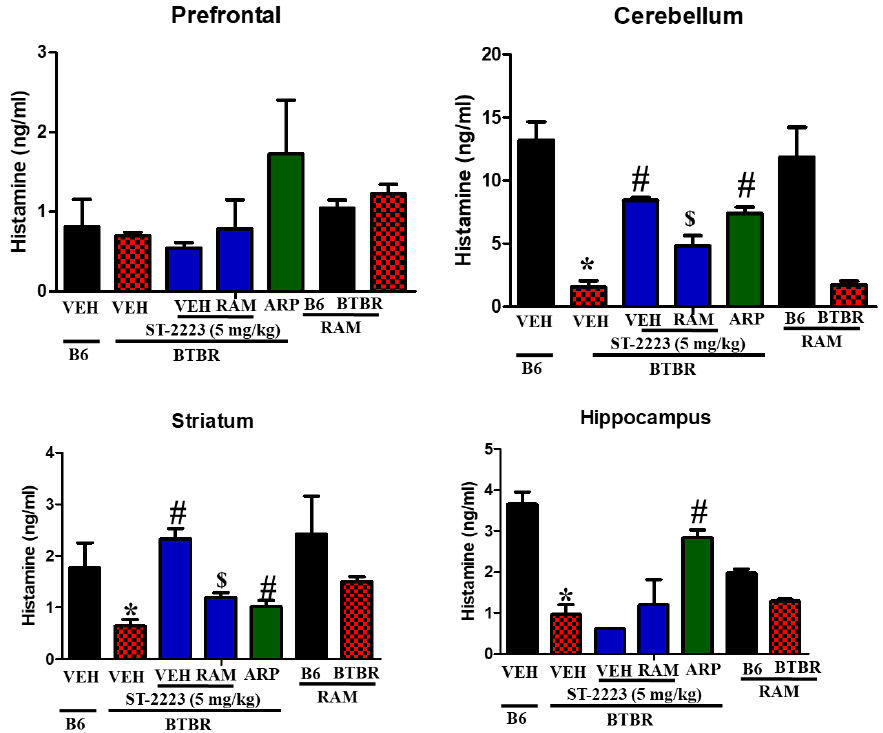
Figure 4. Estimation of histamine levels by LC-MS/MS in different brain regions of BTBR. * p < 0.05 compared to VEH- treated B6 mice. # p < 0.05 compared to VEH-treated BTBR mice. $ p < 0.05 compared to ST-2223-(5 mg)-treated BTBR mice. Data are expressed as the mean ± SEM (n = 5).